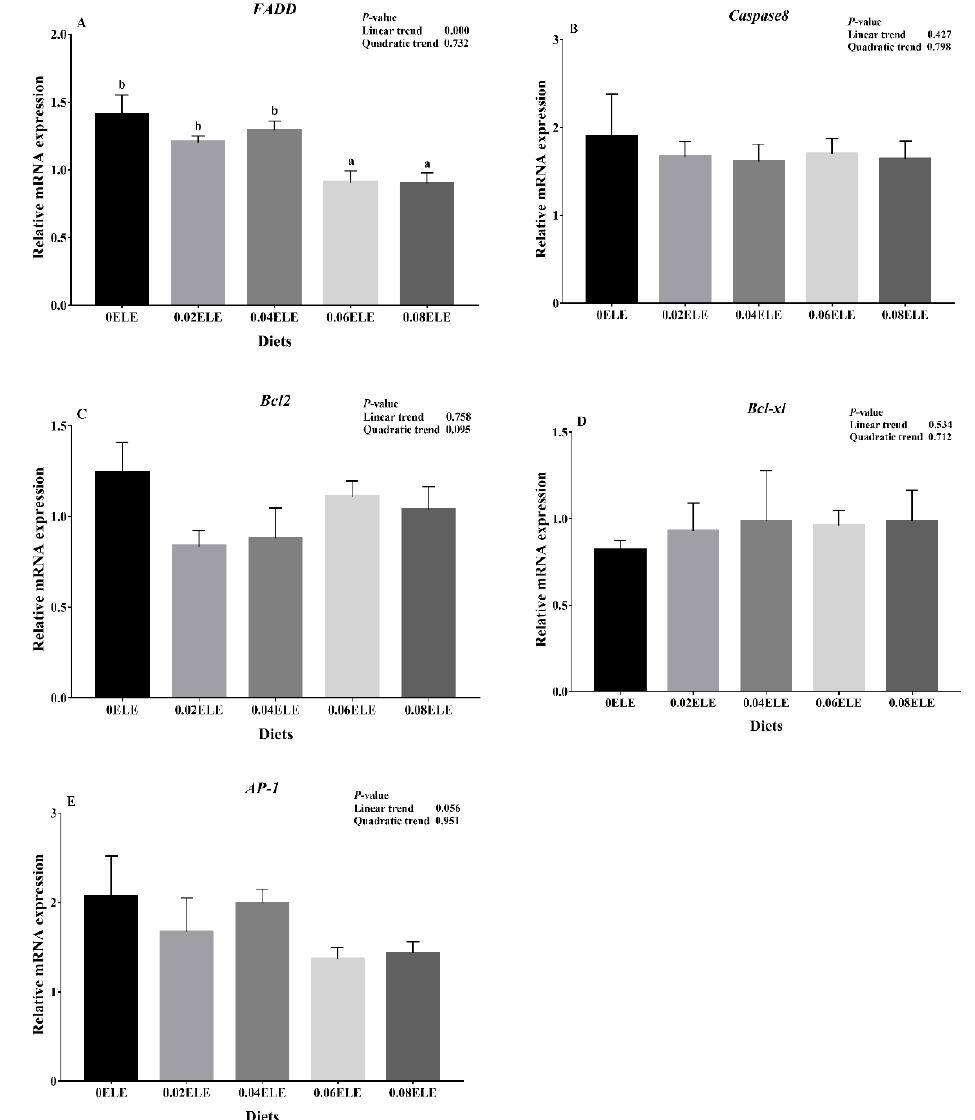
Figure 5. Relative expressions of apoptosis signaling pathway with different ELE levels. FADD ( A ); Caspase8 ( B ); Bcl2 ( C ); Bcl-xl ( D ); AP-1 ( E ). Data are expressed as means ± S.E.M., value with different letters (a, b) are significantly different ( p < letters (a, b) are significantly different ( p < 0.05).